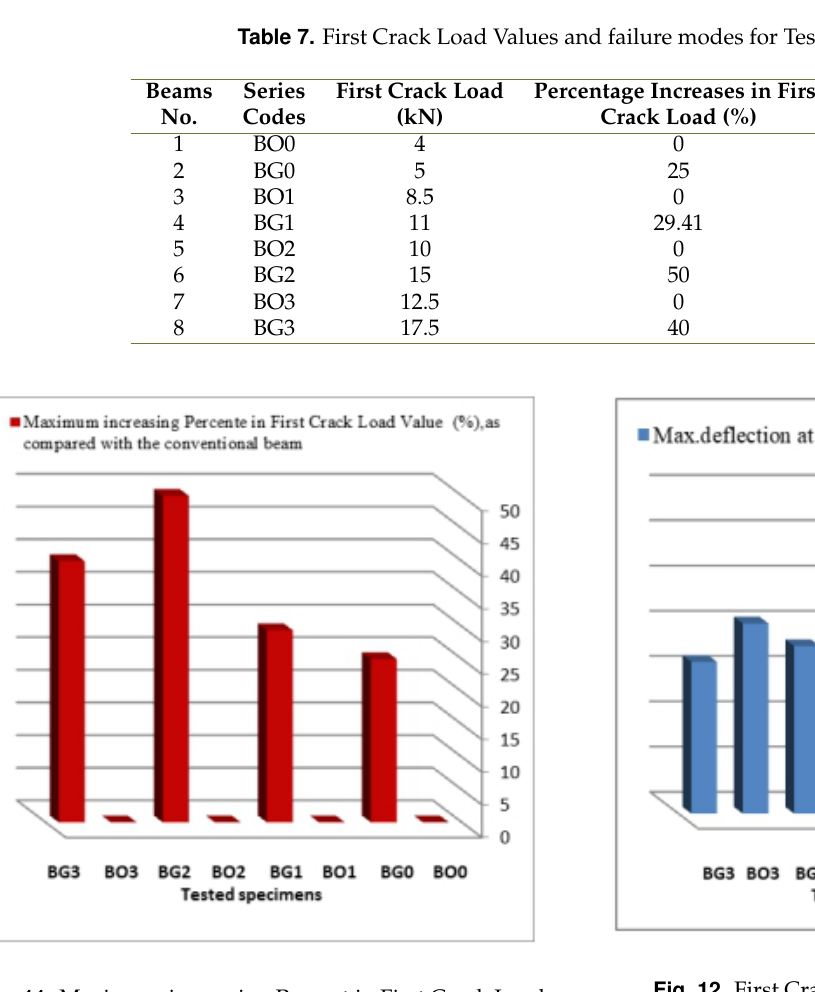
Fig. 11. Maximum increasing Percent in First Crack Load Value 27.87%, 26.73% and 20.24% as compared with the con-